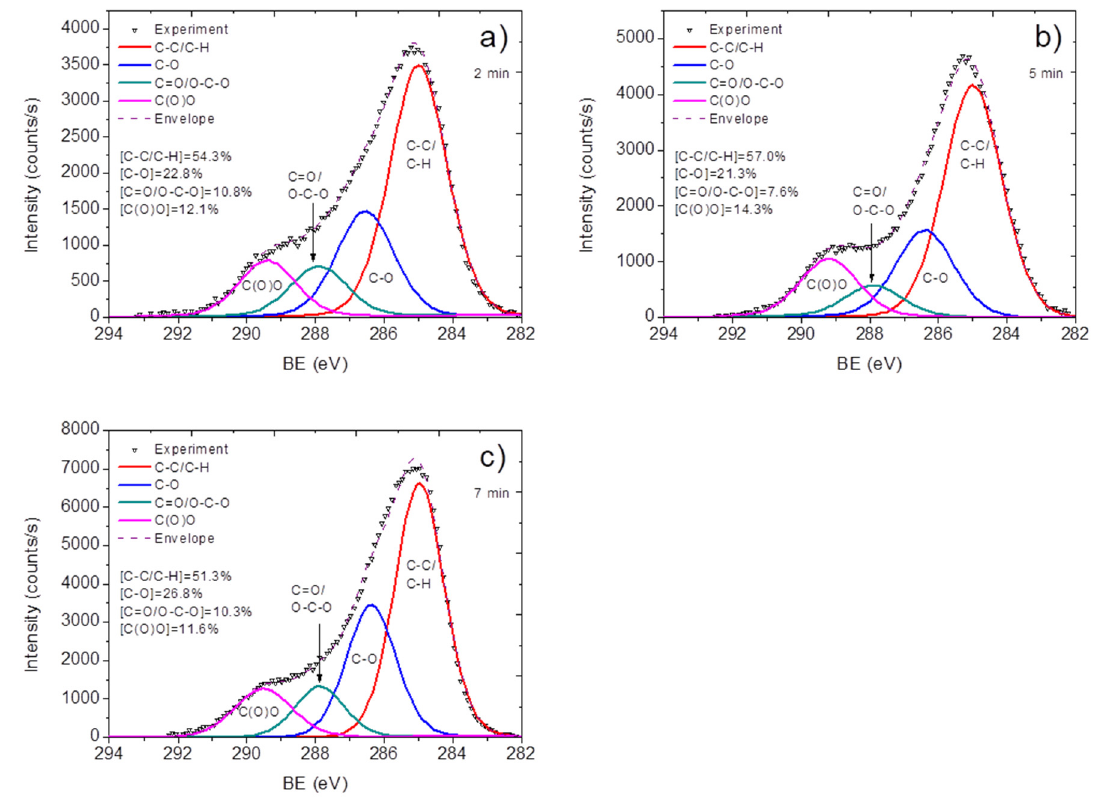
Figure 4. XPS spectra of MWCNT samples after being plasma-treated for 2 min ( a ), 5 min ( b ), and 7 min ( c ).